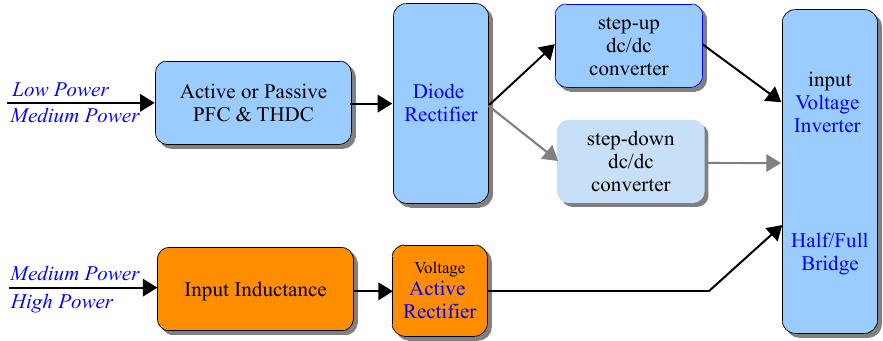
Figure 8. Power electronics configurations on the primary.